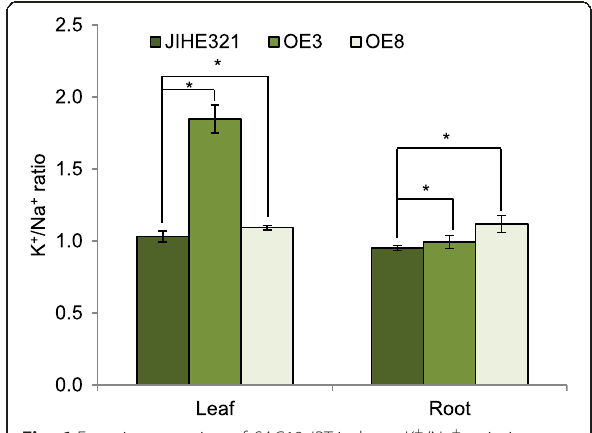
Fig. 6 Ectopic-expression of SAG12::IPT induces K + /Na + ratio in cotton leaves. The third true leaf and root samples (0.5 g) of transgenic lines and control cotton were collected after 220 mmol·L − 1 NaCl treatment for 7 days. The K + /Na + ratio was calculated by dividing K + content by Na + content. The data are shown as means ± SD from three repeats ( n = 3, * P ≤